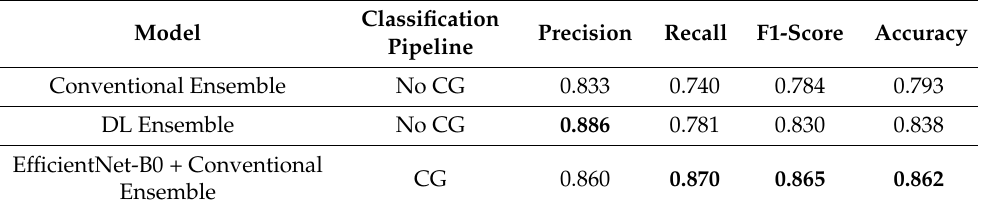
Table 4. The table presents the classification metrics for the pipelines with the highest accuracy across each of the different pipelines used for classification. CG stands for cascade